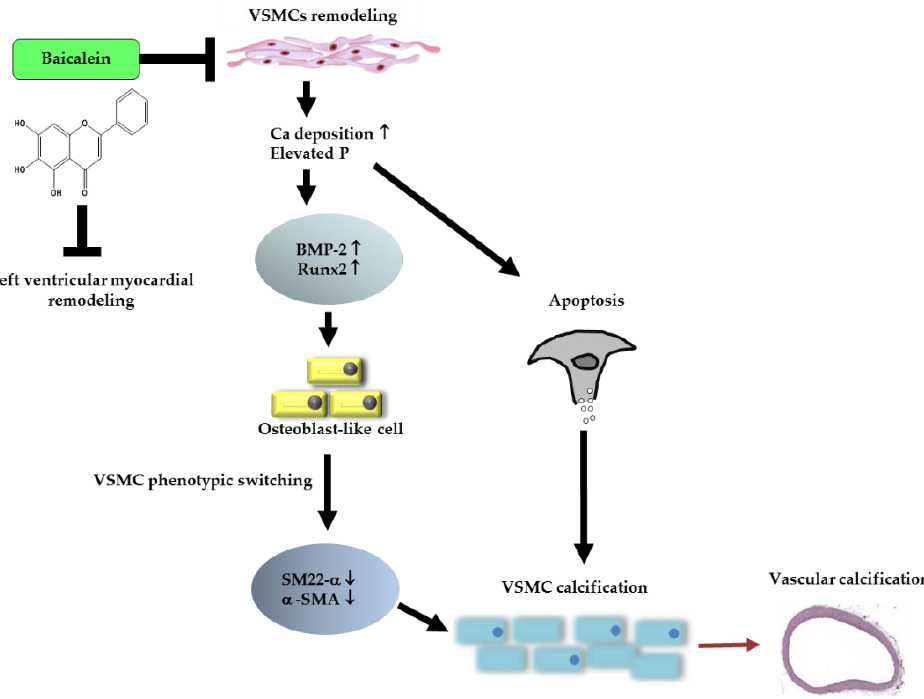
Figure 9. Proposed mechanisms of baicalein inhibits vascular calcification. Baicalein ameliorates calcium and phosphate homeostasis, leading to the downregulation of Runx2 and BMP-2 expressions. Furthermore, baicalein blocks VSMC calcification by restoring the SM22- α and α -SMA; VSMC- related contraction biomarkers. Somewhat surprisingly, we found that baicalein pretreatment inhibits cardiac